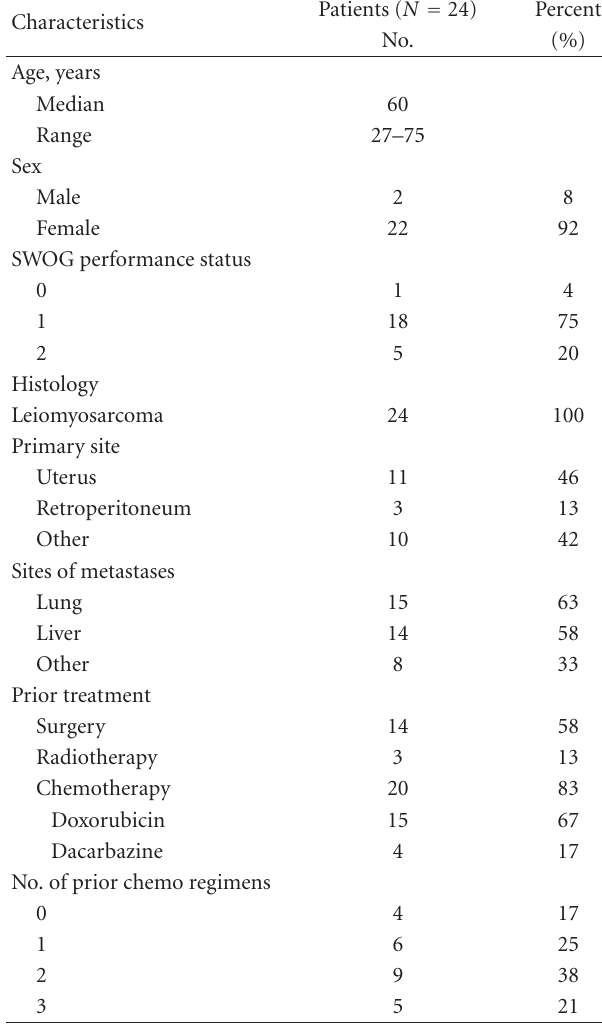
Table 1: Baseline patient